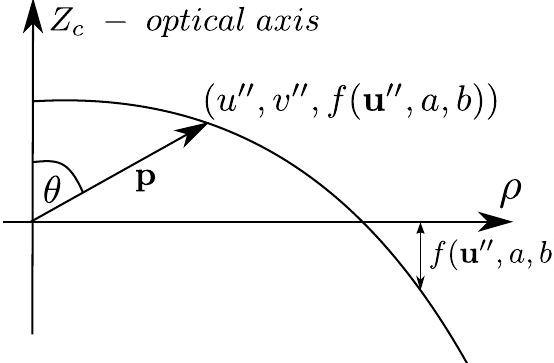
Figure 2: The diagram showing the relation between the back- projected image point and the function f